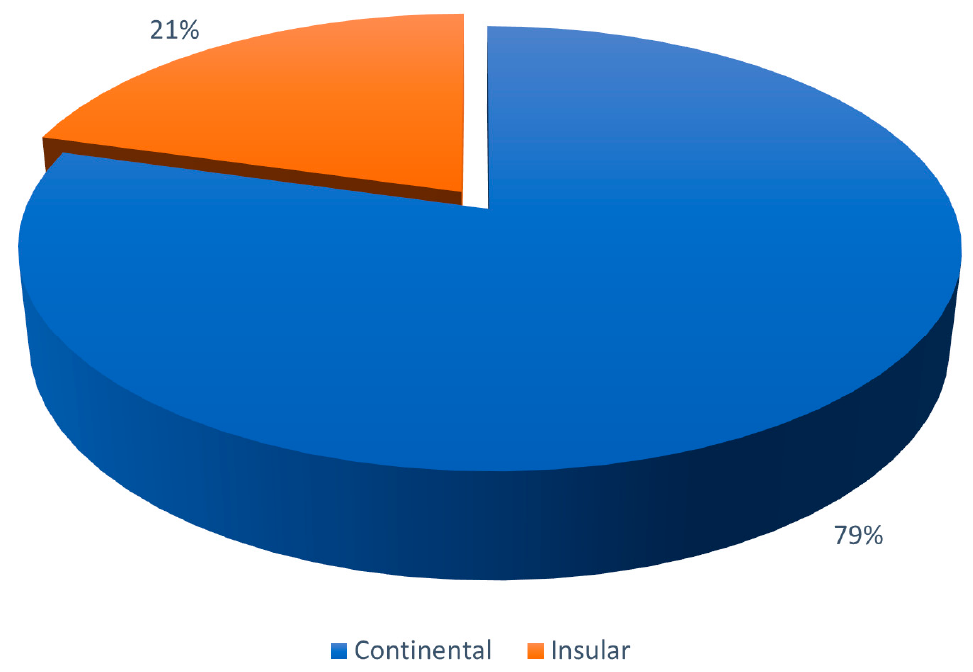
Figure 8. Percentage of all “Extreme rainfall and floods” articles of Mediterranean bioregion. The analysis of the geographical distribution of the articles on “Extreme rainfall and floods”, focused on the Mediterranean insular bioregion (Figure 9), showed that most of the articles had Sicily (76%; 16 articles) as study area, followed by Sardinia (19%; 4 articles) and Cyprus (5%; 1 articles).